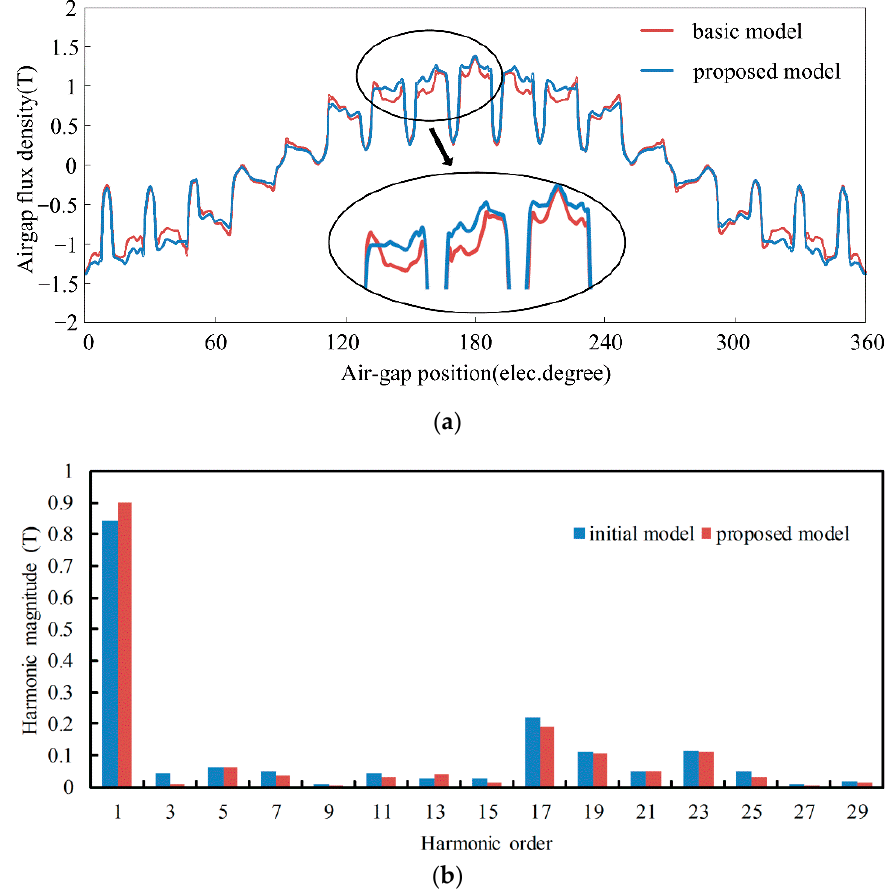
Figure 13. Comparison of the radial flux density distributions: ( a ) flux density; ( b ) FFT of the flux density.